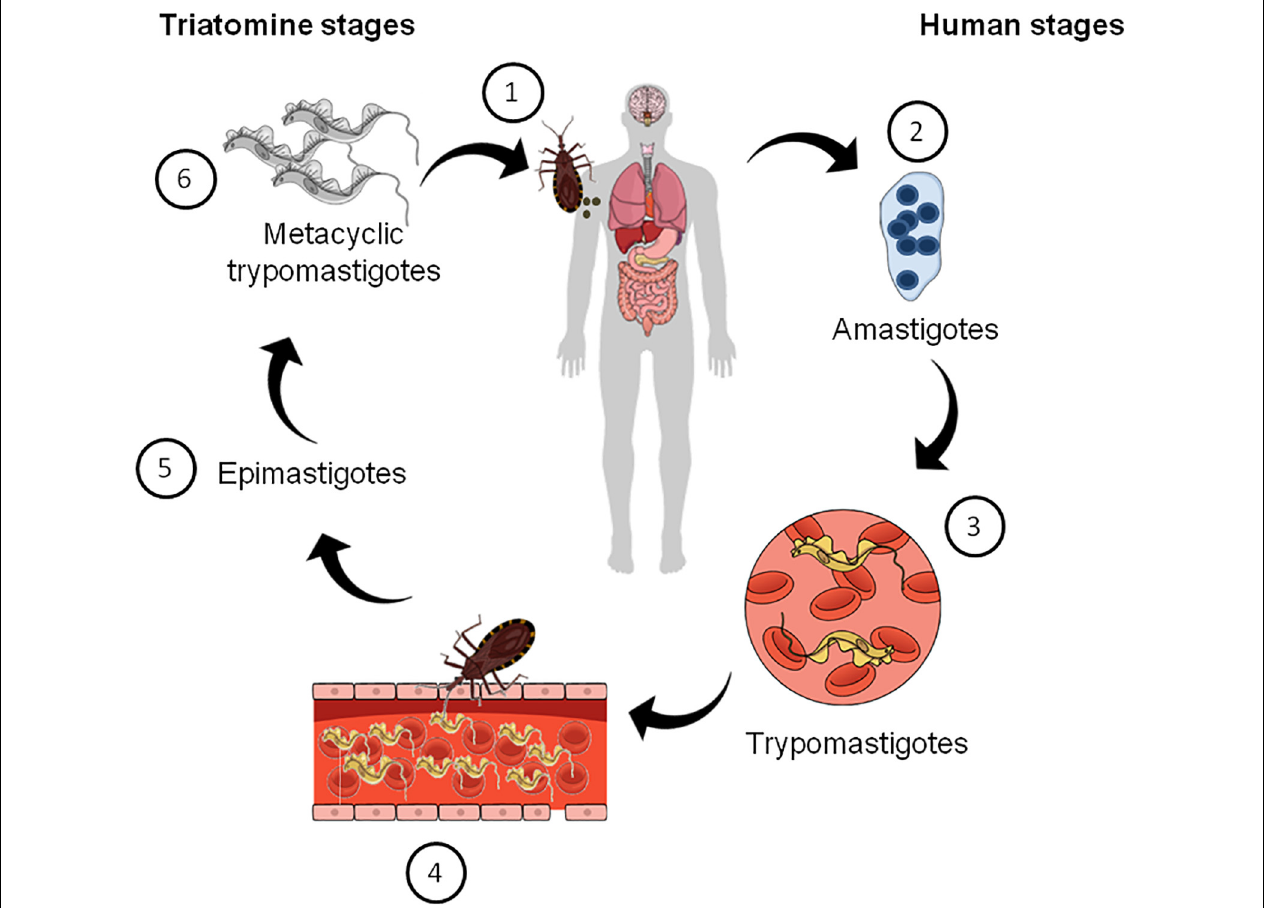
FIGURE 1 | Schematic summarizing the life cycle of Trypanosoma cruzi . (1) Triatomine bugs take a blood meal and passes metacyclic trypomastigotes in their feces, which then enter the host via bite wounds or mucosal membranes. Metacyclic trypomastigotes now invade host cells (not shown) and become amastigotes , which multiple inside the infected cells (2). Amastigotes then transform into trypomastigotes , which then cause cell lysis and their release into the bloodstream (3). Triatomine bugs become infected when they feed on an infected mammalian host (4). Inside the insect vector, trypomastigotes now transform into epimastigotes in the insect gut (5). Finally, epimastigotes transform into infective metacyclic trypomastigotes (6), which are released in the feces and the cycle